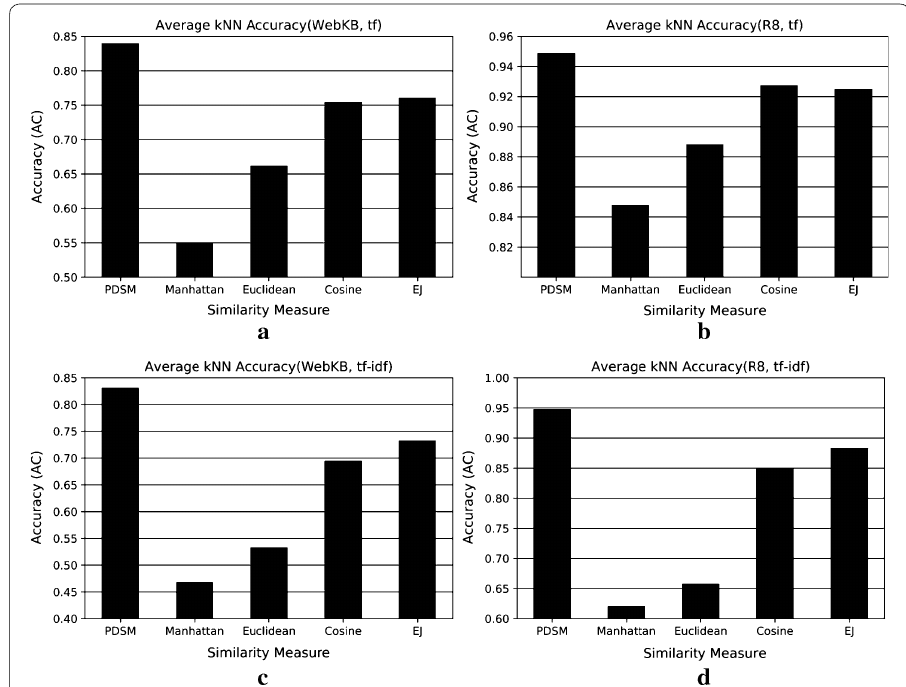
Fig. 2 Average accuracy of k NN on the test set with PDSM: a WebKB, tf. b R8, tf. c WebKB, tf-idf. d R8, tf-idf